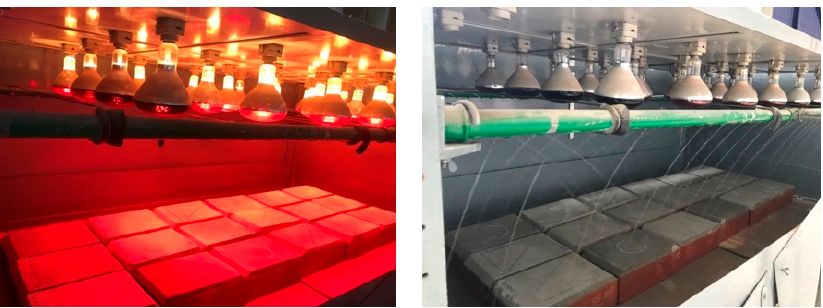
Figure 3. Illustration of the artificial ageing.